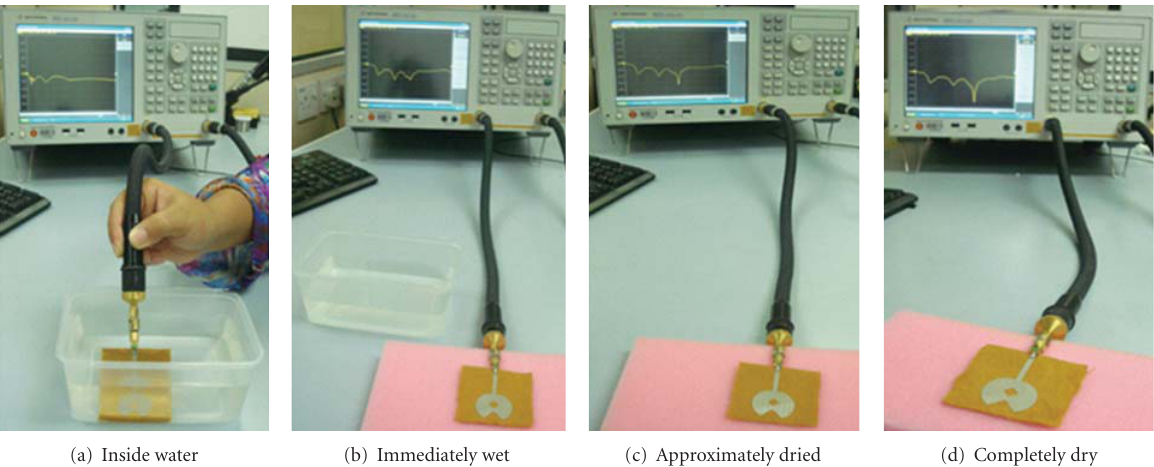
Figure 13: Snapshots of measured results of UWB antenna prototype using Shieldit conducting fabric considering di ff erent states of wetness, dampness, and fully